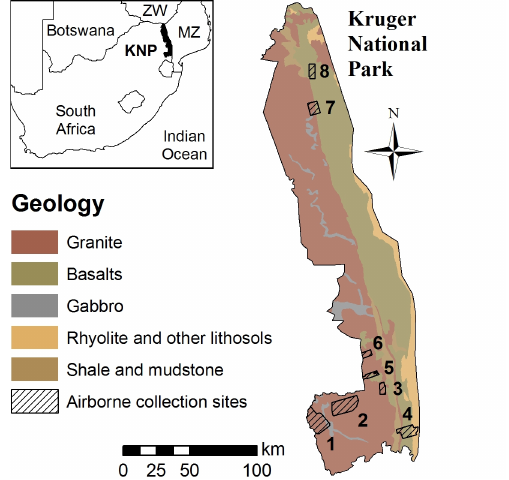
Fig. 1. Study site locations and geology. Numbers correspond to site ID in Table 1. Zw=Zimbabwe, MZ=Mozambique, KNP=Kruger National